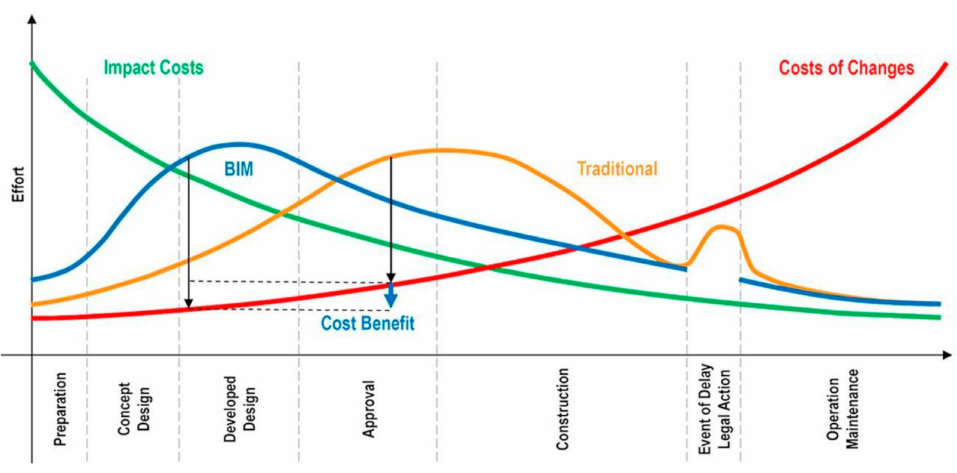
Figure 3. BIM vs. traditional CAD planning. Source: MacLeamy and Liebich,